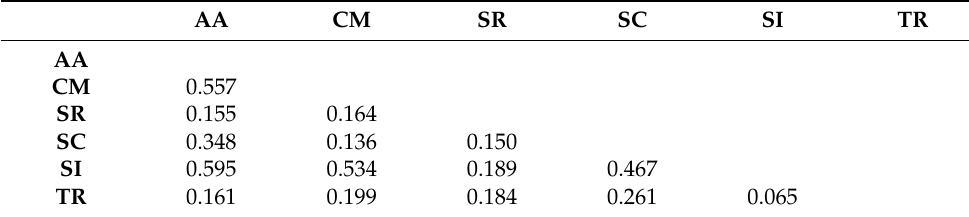
Table 3. Heterotrait-monotrait ratio (HTMT).